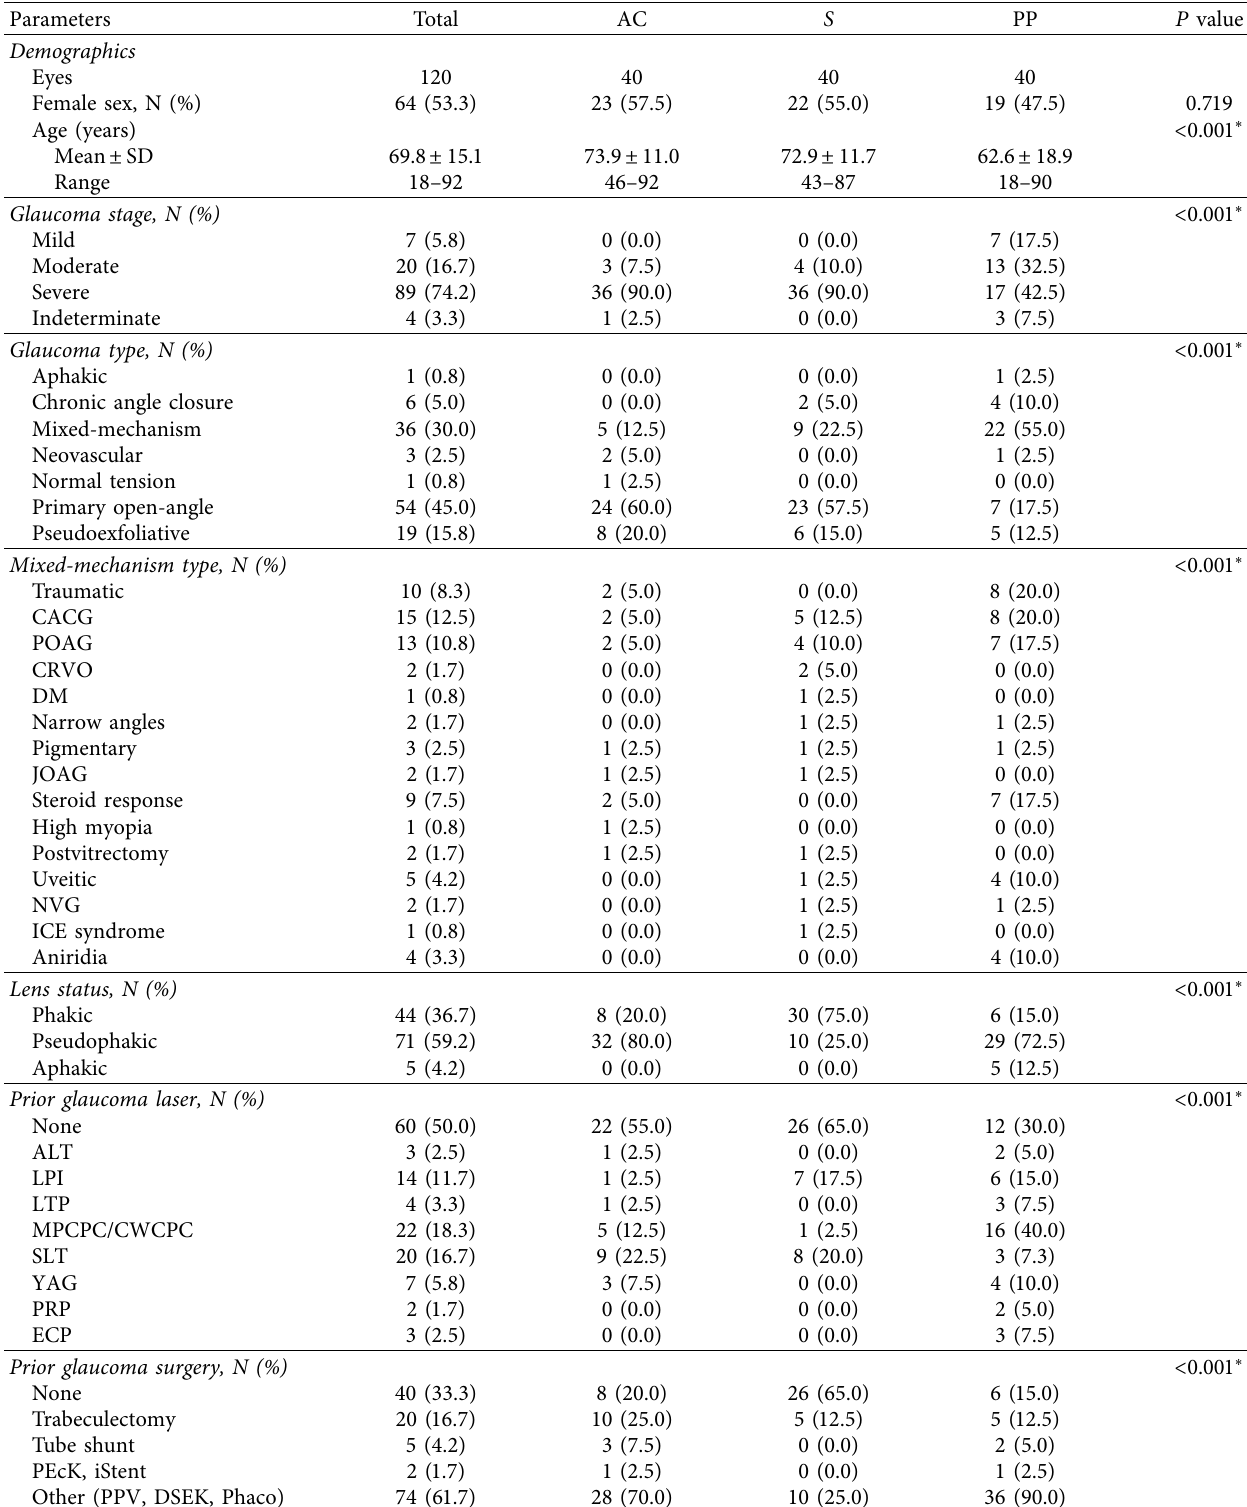
Table 1: Demographic and ocular data a